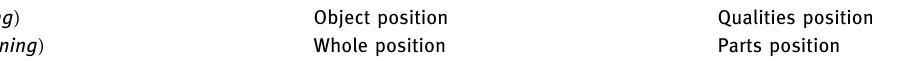
Table 1: Four ways an aesthetic element participates in allure Allusion ( anti - overmining